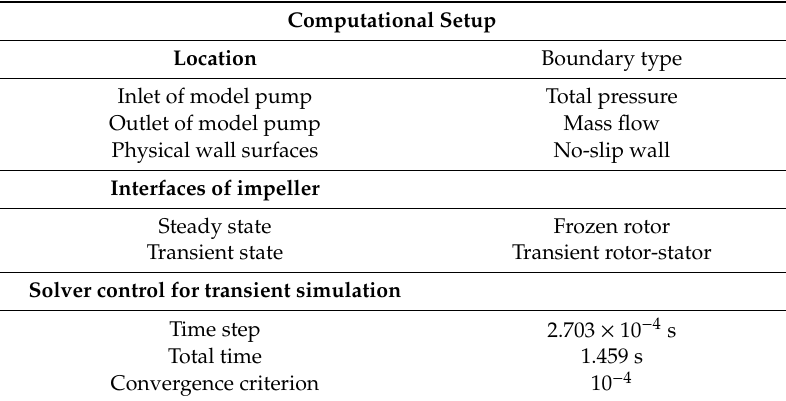
Table 3. Computational